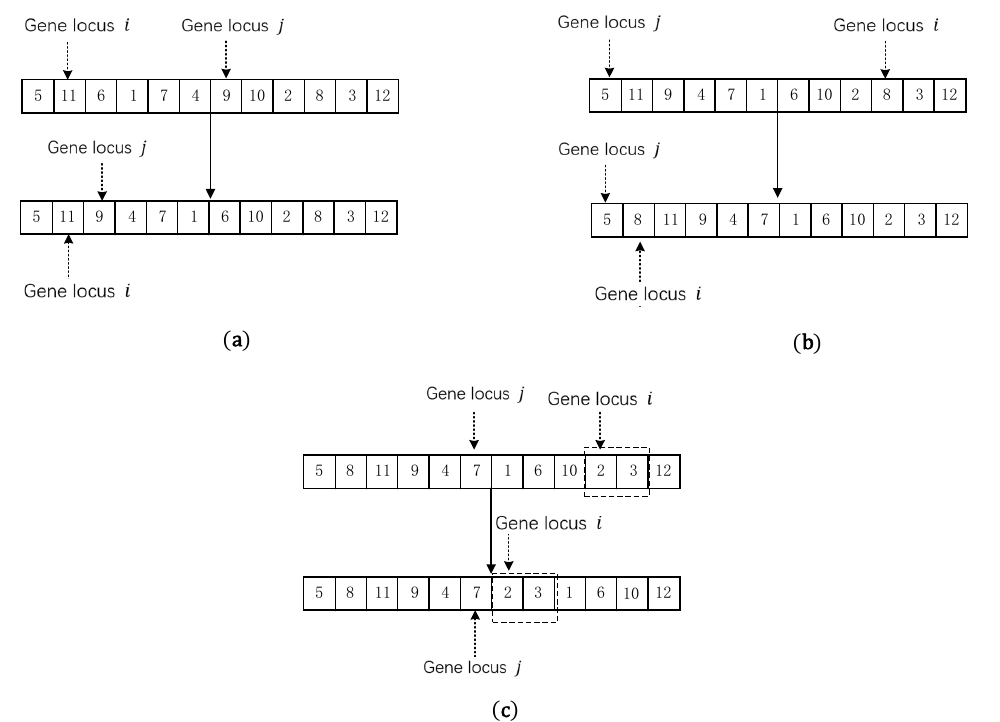
Figure 6. Variable neighborhood descent operator. ( a ) An example of gene fragment inversion process; ( b ) an example of single locus insertion process; ( c ) an example of double locus insertion process.